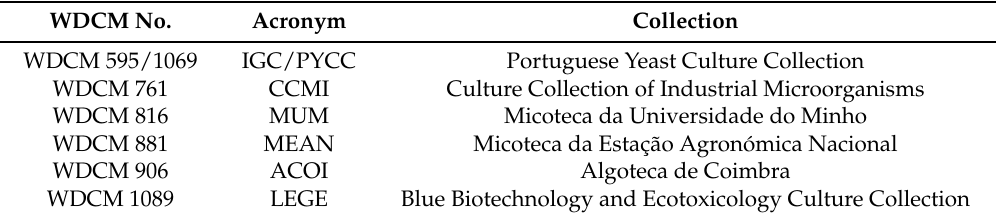
Table 1. Portuguese culture collections registered at the World Data Centre for Microorganisms (Adapted from: